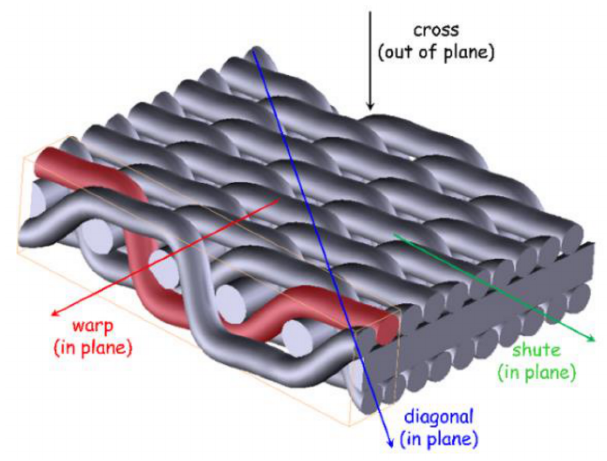
Figure 4. Metallic-cloth fibers and flow